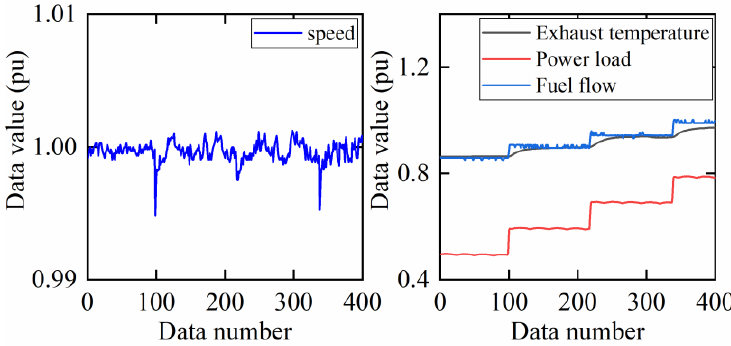
Figure 9. Gas turbine model testing data